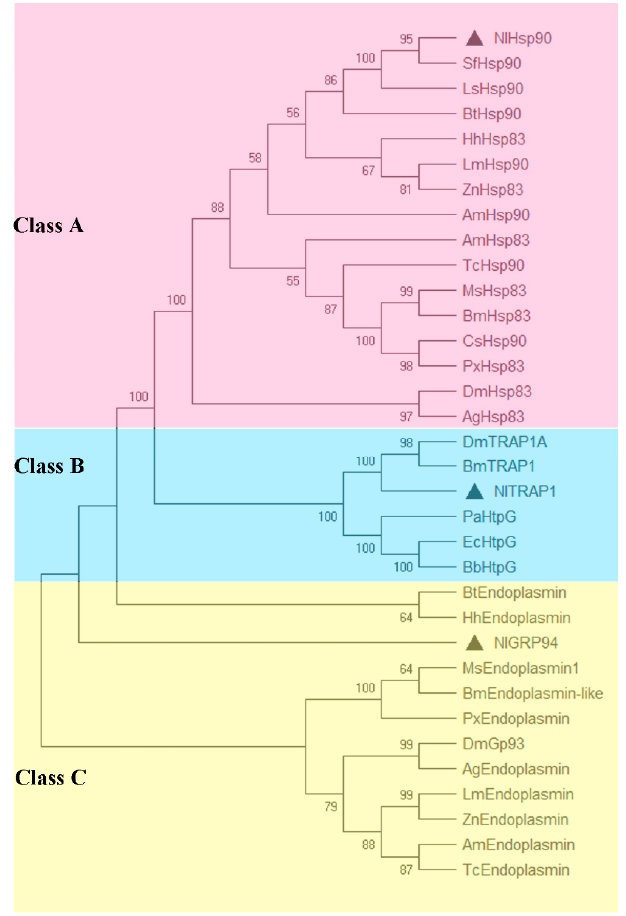
Figure 2. Phylogenetic analysis of the Hsp90 family members in BPH. The phylogenetic tree was constructed based on 34 Hsp90s from 18 species (see Table S2) using the neighbor-joining method, and bootstraps were set with 1000 replications. The Hsp90 members of BPH are shown with black